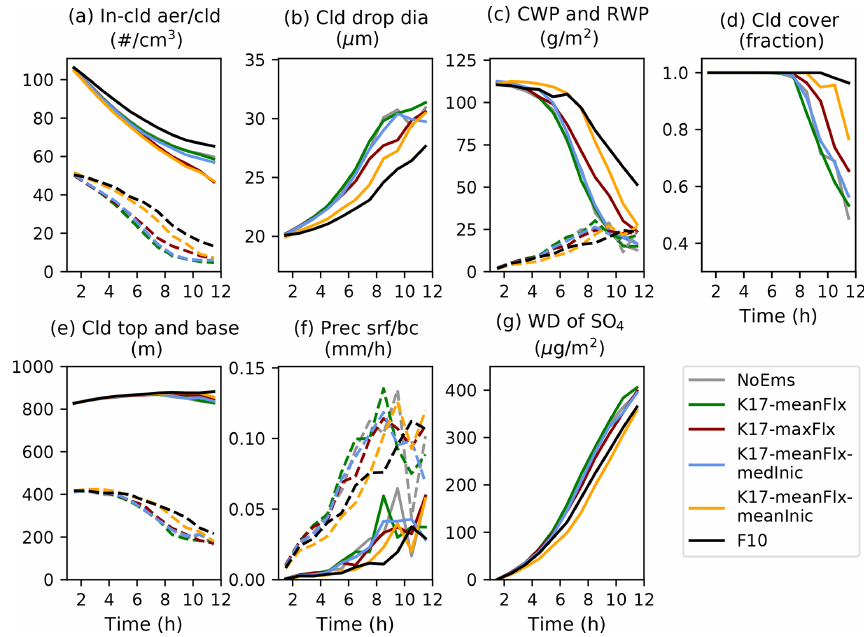
Figure 6. Impact of VOC emissions. Panels are the same as Fig. 3. Grey – no emission; green – mean fluxes of monoterpenes and isoprene from Kim et al. (2017); dark red – maximum fluxes; blue – initialized with observed median concentrations, mean fluxes emitted; yellow – initialized with mean observed concentrations, mean fluxes emitted; black – base (F10 sea spray, no VOC) for comparison.